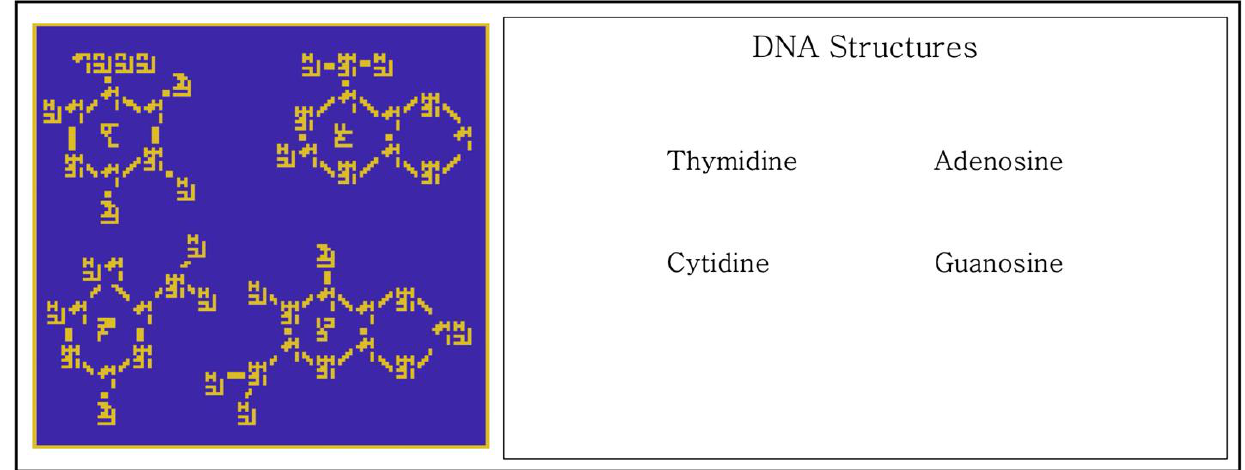
Figure 13. Pictural representation of DNA in the message, Page 7.